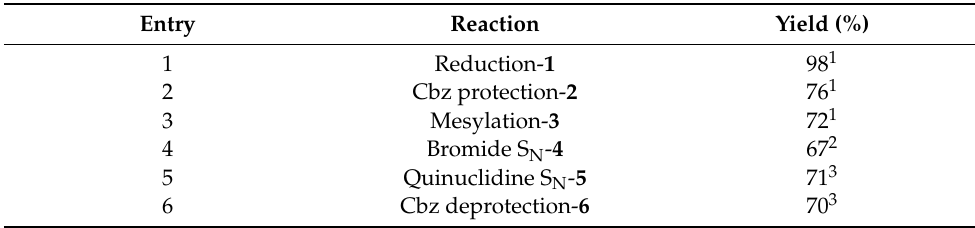
Table 1. Yields towards the synthesis of 6 . Entry Reaction Yield (%) 1 Reduction- 1 98